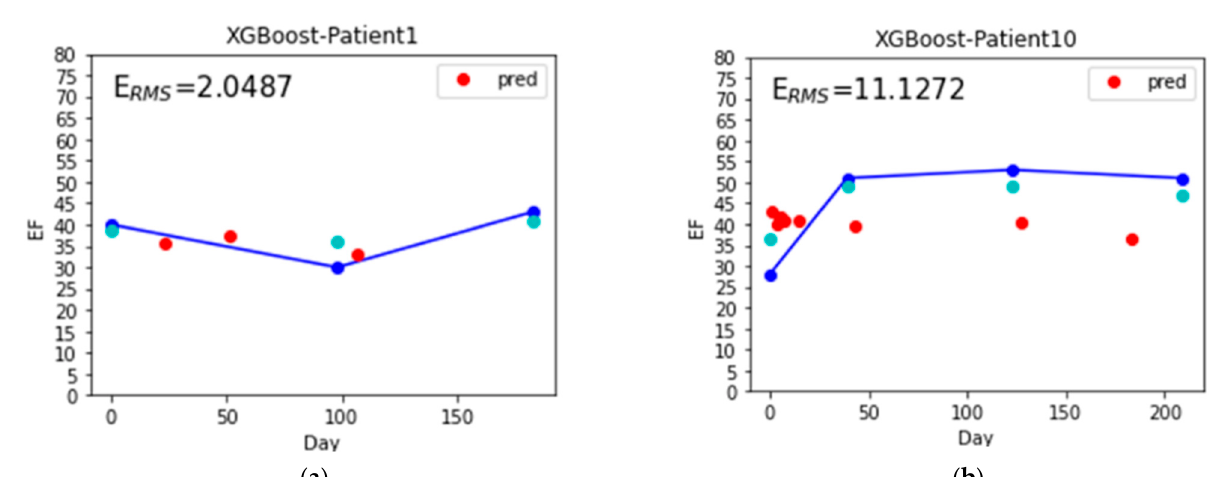
Figure 13. The estimated LVEF for the lowest and highest E RMS values by XGBoost, the blue points are the LVEF measured by the echocardiography, green points are the estimated LVEF of training model, and red points are the estimated LVEF of the testing model, ( a ) patient 1, and ( b ) patient 10.